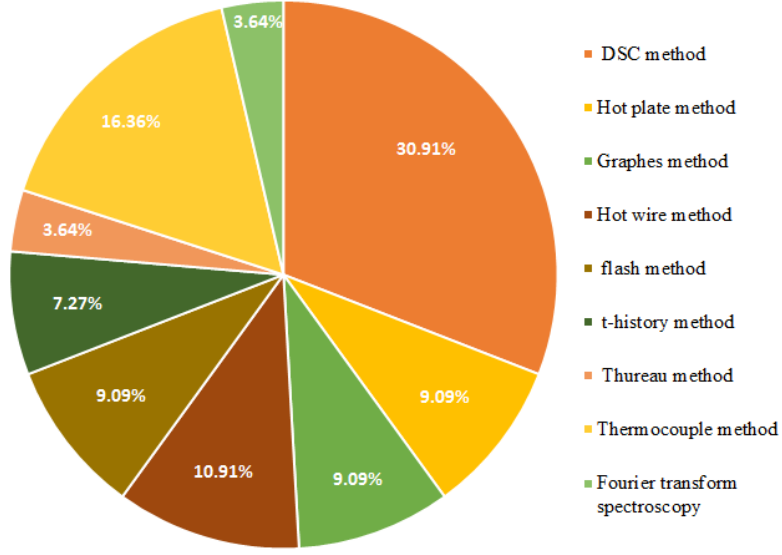
Figure 11. Distribution of Experimental treatment through Type used in examined literature papers.